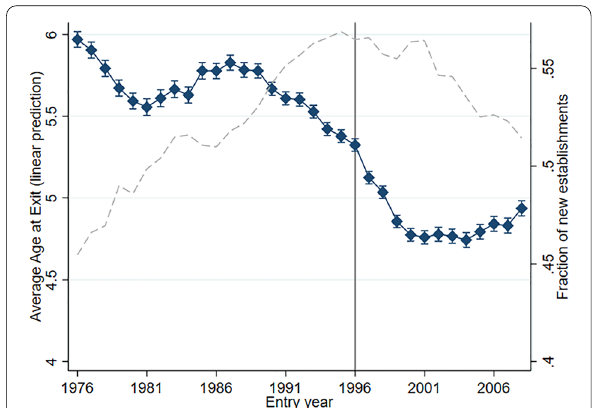
Fig. 6 Evolution of exit dynamics by entry year. Left y-axis: Average age at exit. Right y-axis: Fraction of new establishments that exited within 10 years. For the average age at exit only those establishments were considered that exited within their first 10 years of